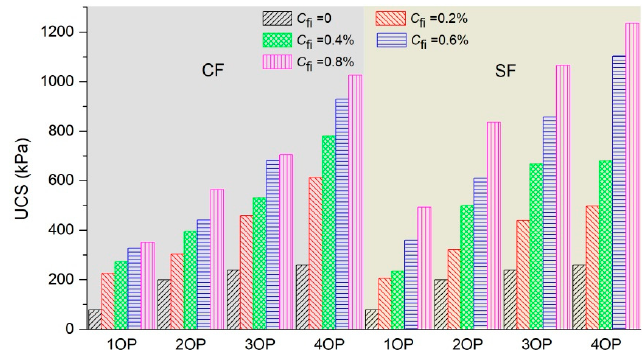
Figure 8. The UCS of OPSS, OPCFRS, and OPSFRS.